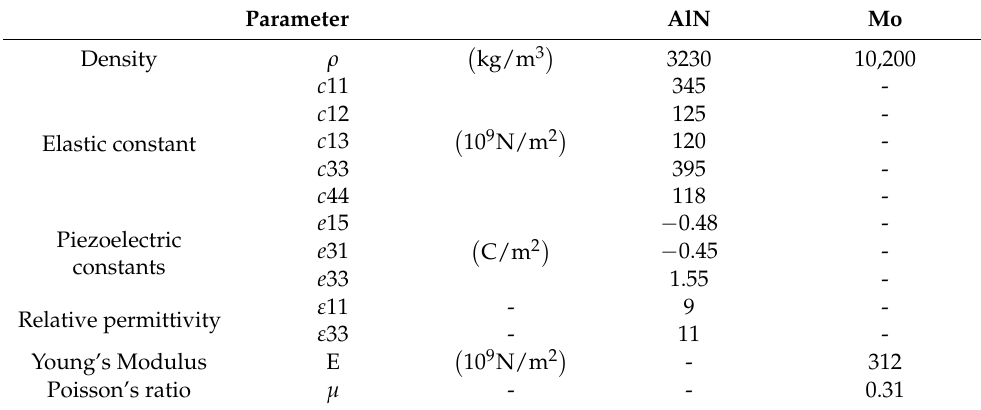
Table 1. The material parameters of AlN and